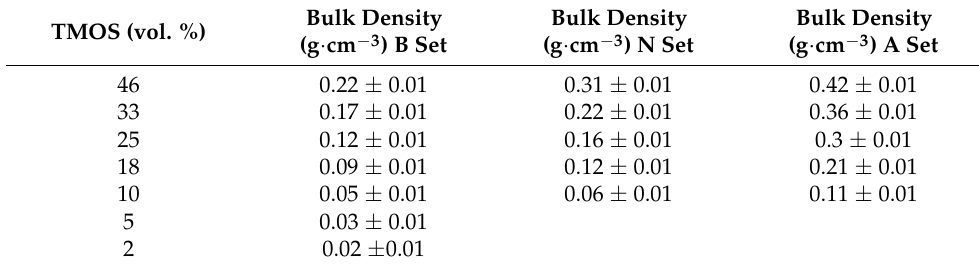
Table 1. Aerogel bulk density versus the TMOS content for the base, neutral and acidic catalysis. TMOS (vol.